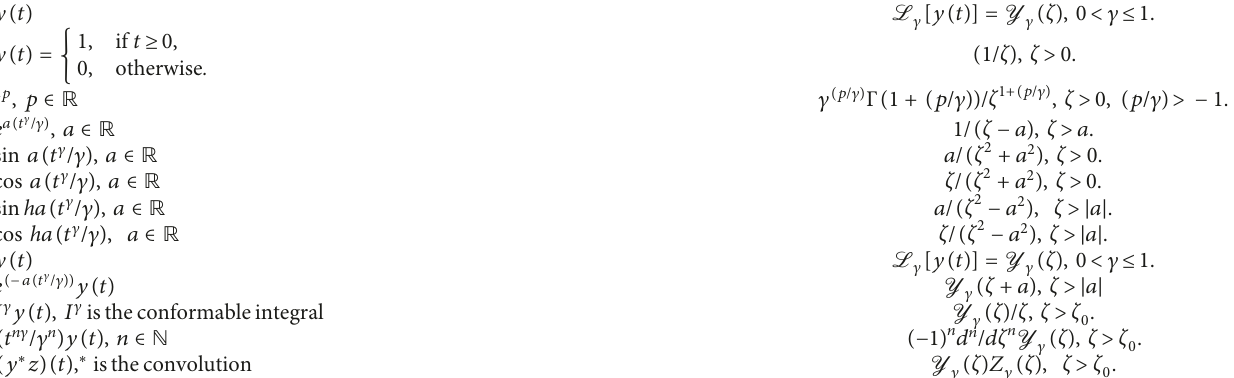
Table 1: Conformable Laplace